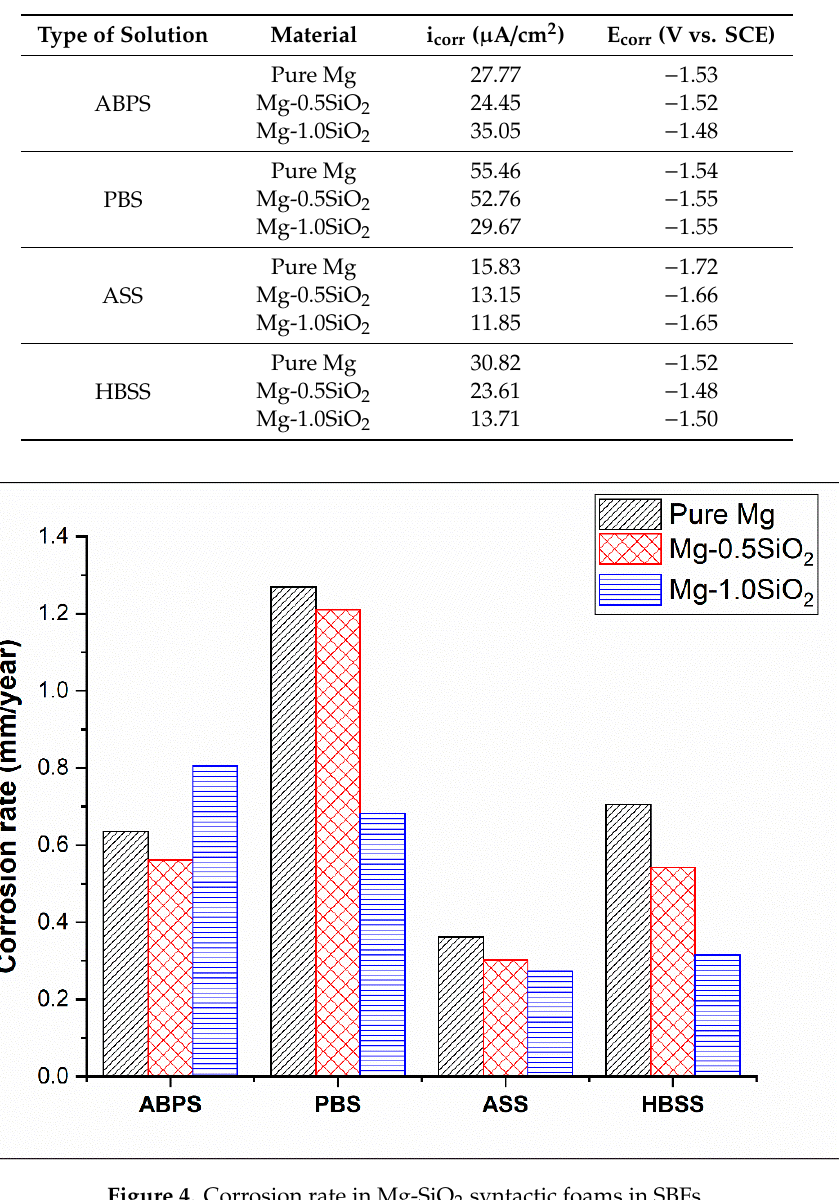
2 syntactic foams in